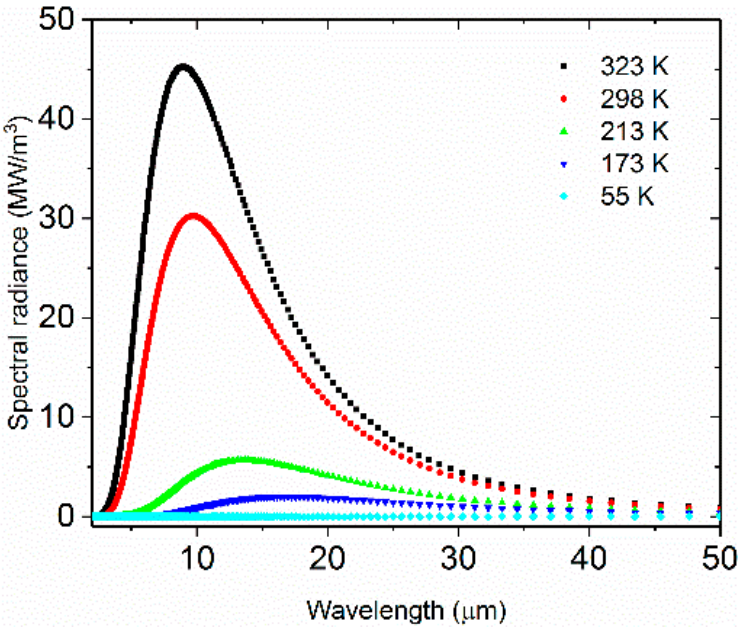
Figure 4. Spectral radiance of blackbody at 55 , 298 and 323 K.